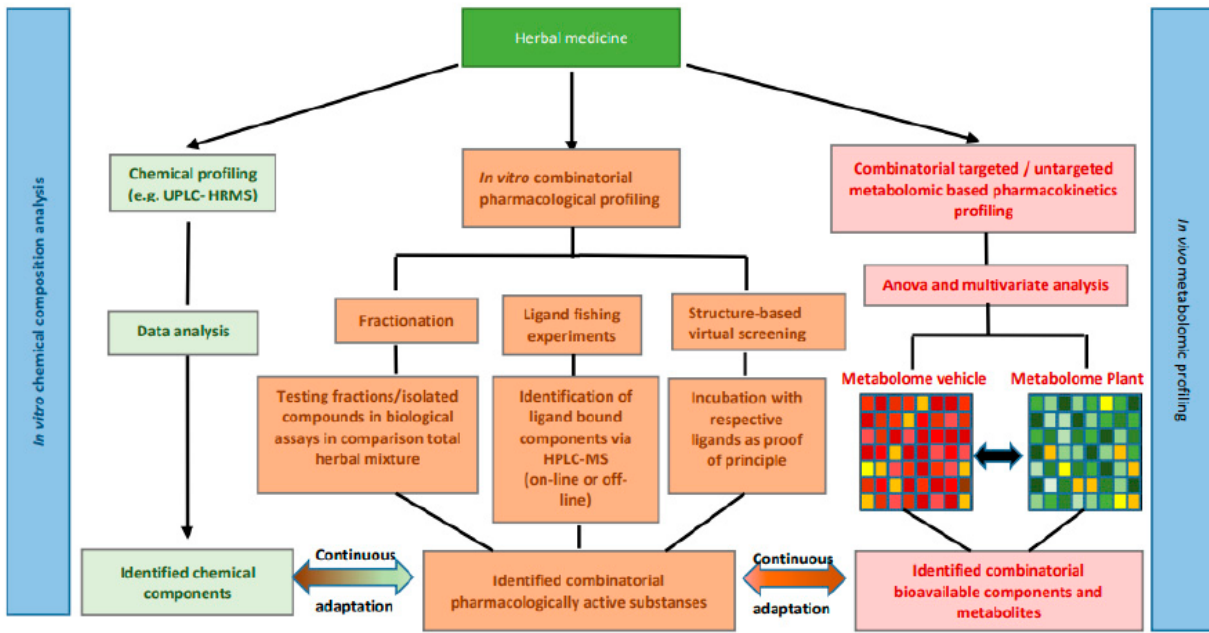
Figure 6. An exemplary overview on a possible approach for conducting combinatorial medicinal plant